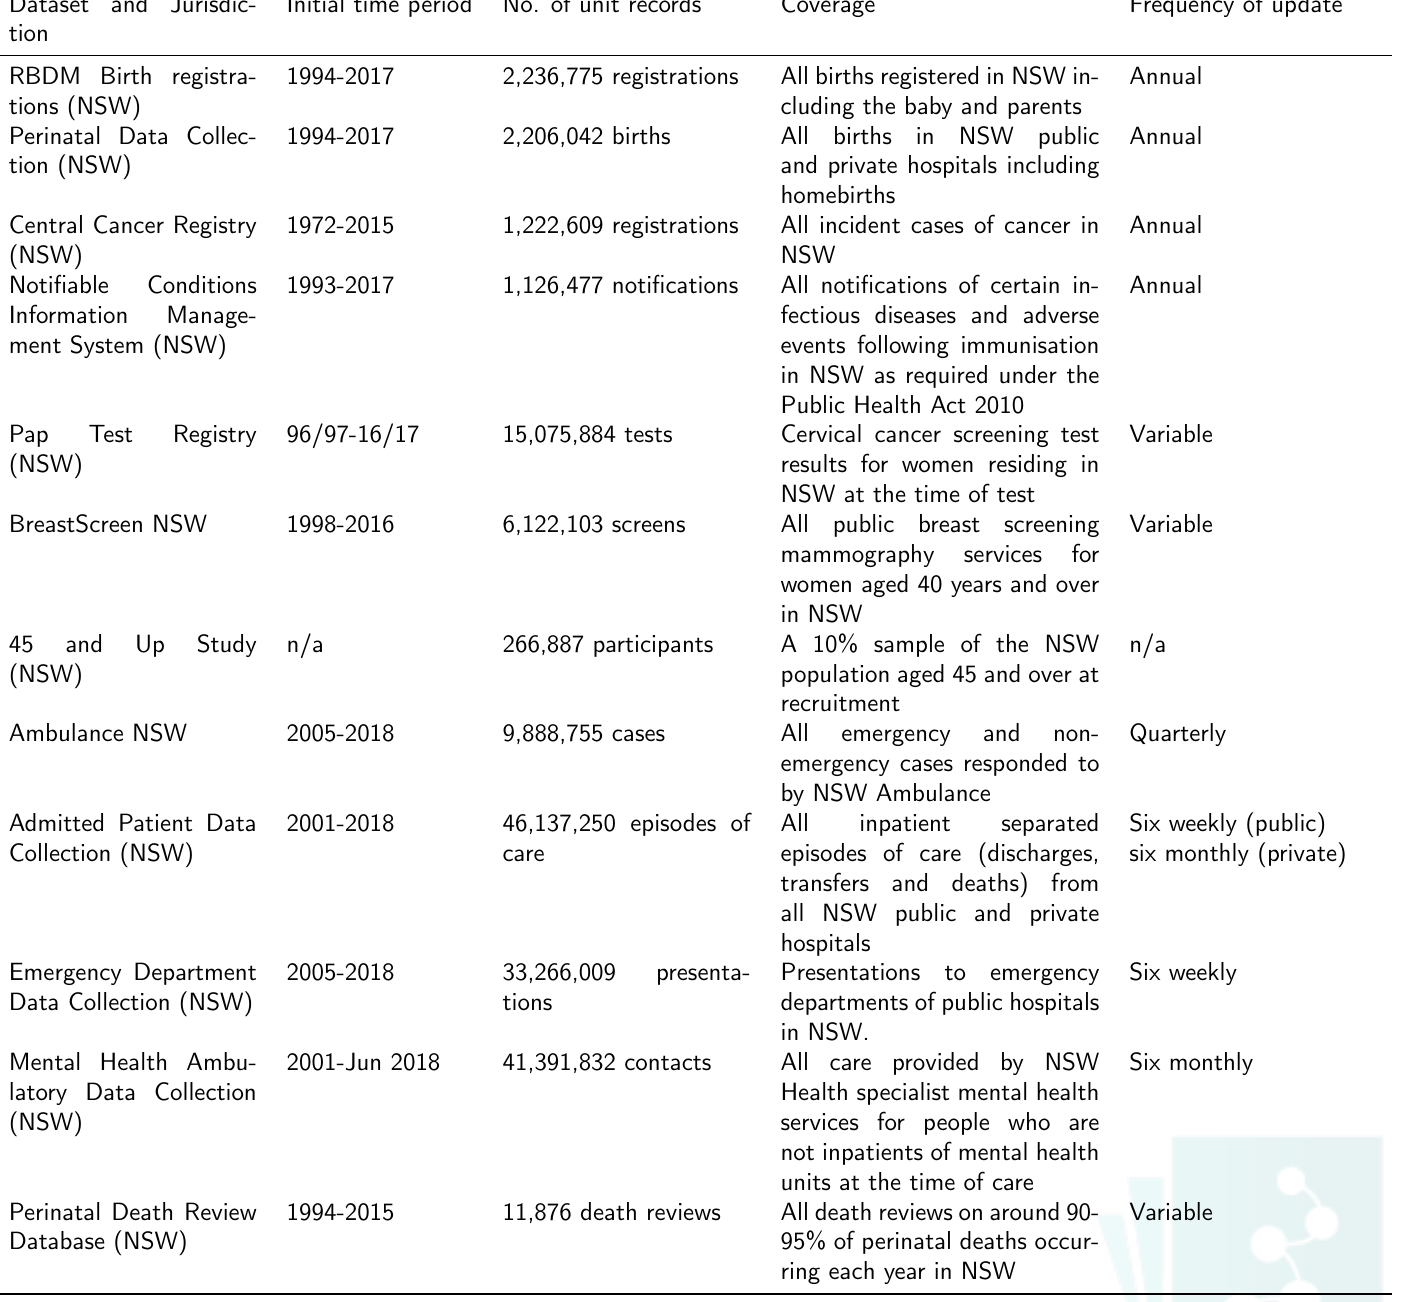
Table 1: Characteristics of data included in the CHeReL Master Linkage Key at April